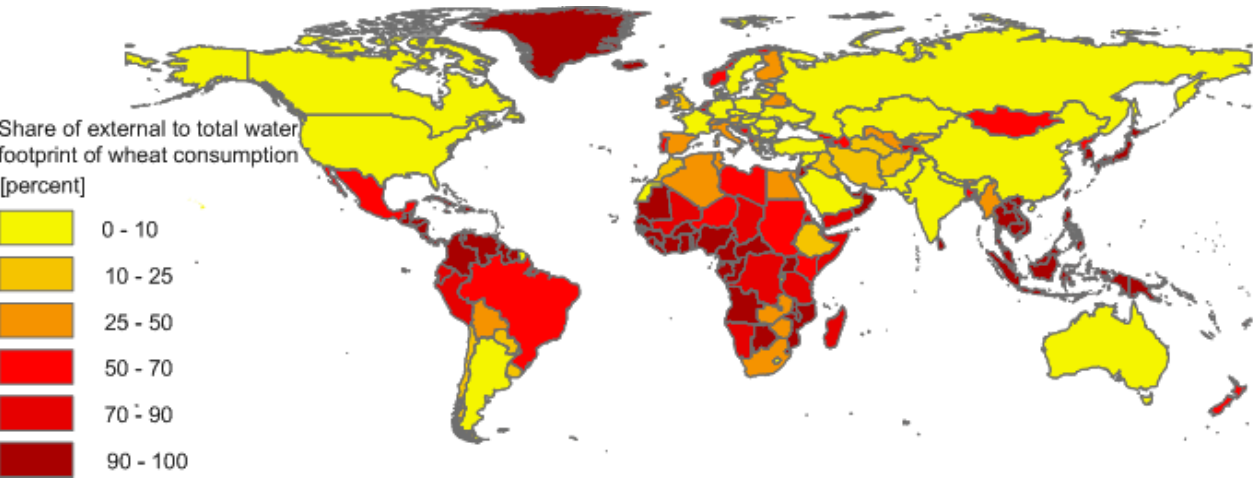
Fig. 6. The extent to which countries rely on external water resources for their wheat consumption. Period: